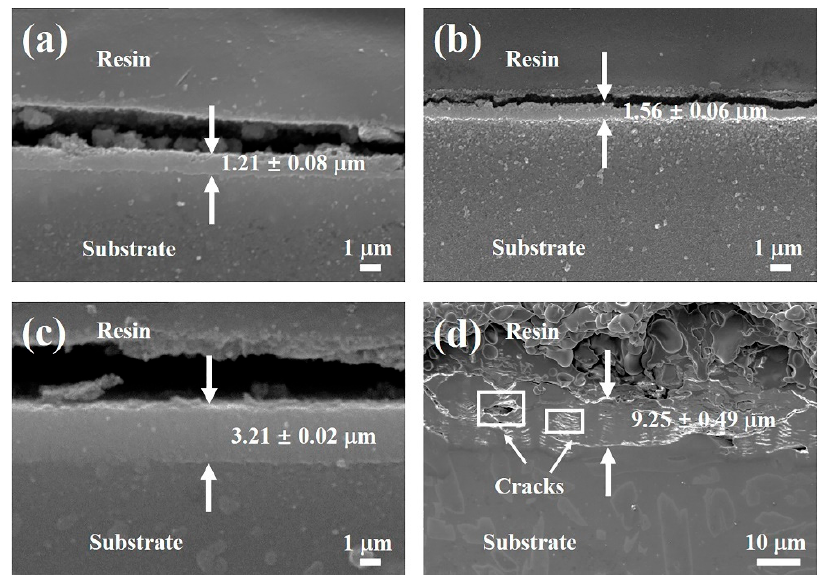
Figure 4. Cross-sectional morphologies of the coated samples: ( a ) 120 °C-coated sample; ( b ) 130 °C-coated sample; ( c ) 140 °C-coated sample; ( d ) 150 °C-coated sample.